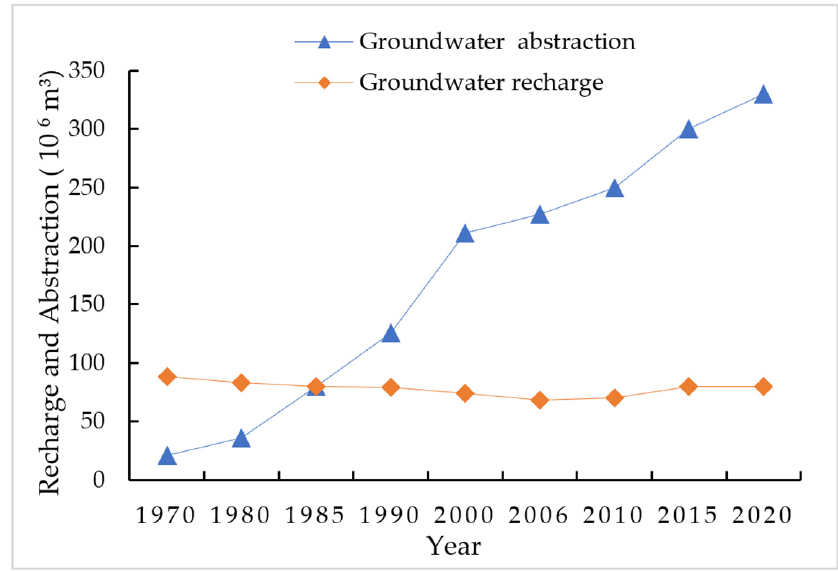
Figure 7. Groundwater abstraction and recharge in Sana’a basin.